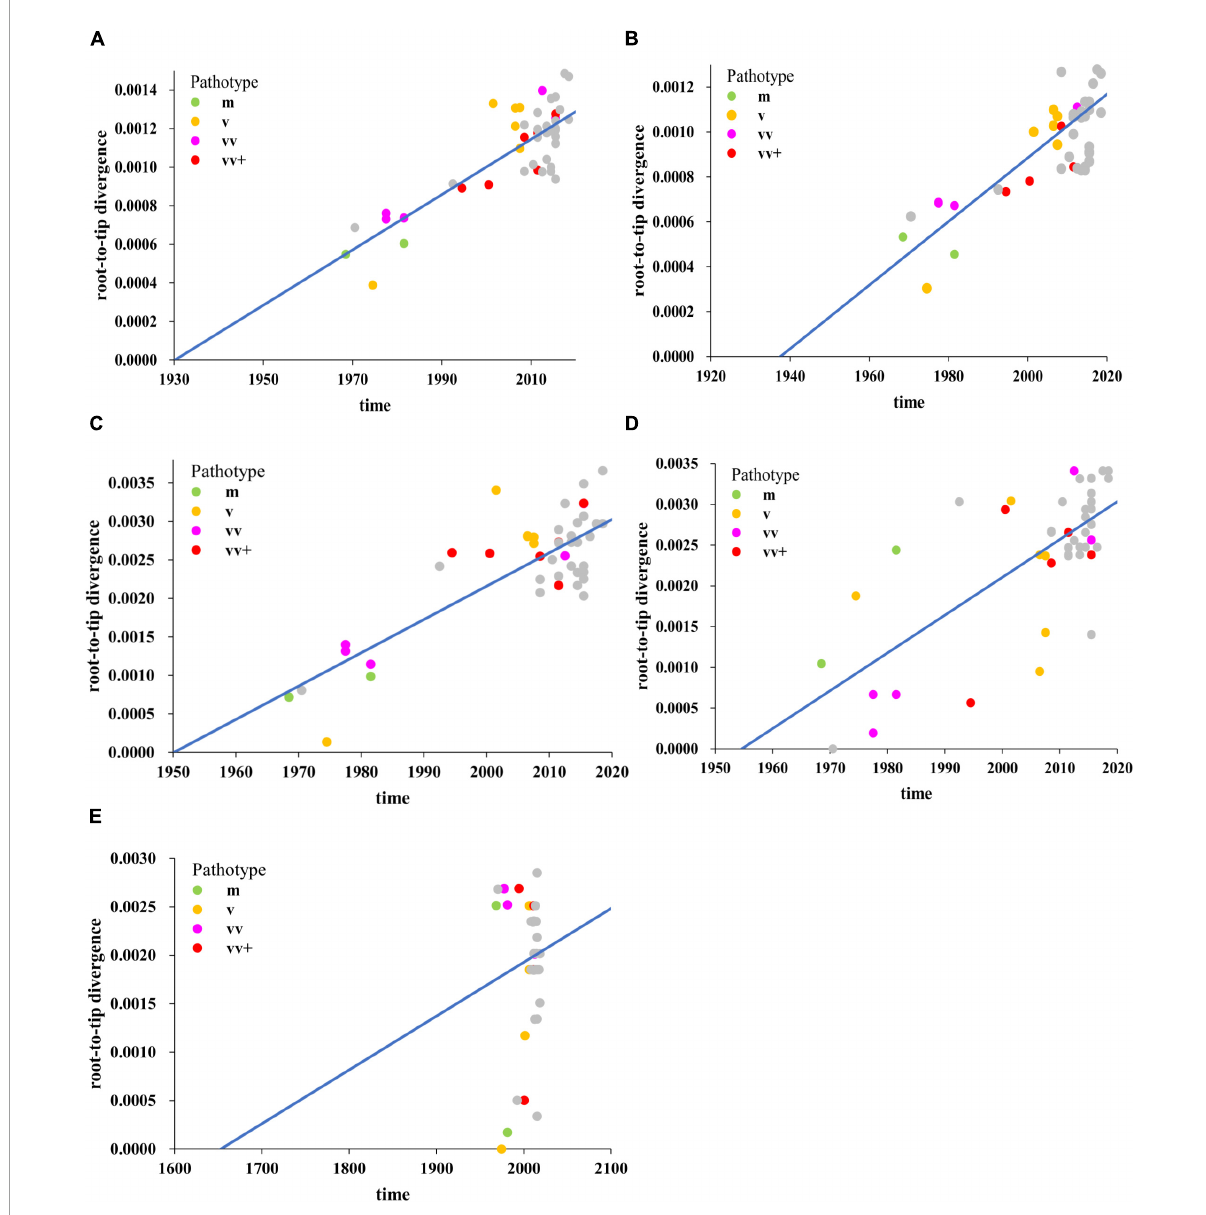
FIGURE1 Regression of root-to-tip genetic distances against year of sampling for Marek’s disease virus (MDV) strains as inferred from the ML phylogenetic tree, including complete genome (A) , unique long (UL) region (B) , internal repeat long (IRL) region (C) , internal repeat short (IRS) region (D) , and unique short (US) region (E) sequences. The mild (m, green), virulent (v, yellow), very virulent (vv, pink), very virulent plus (vv+ , red) MDV, and 26 MDV strains isolated and sequenced in this study (gray) were